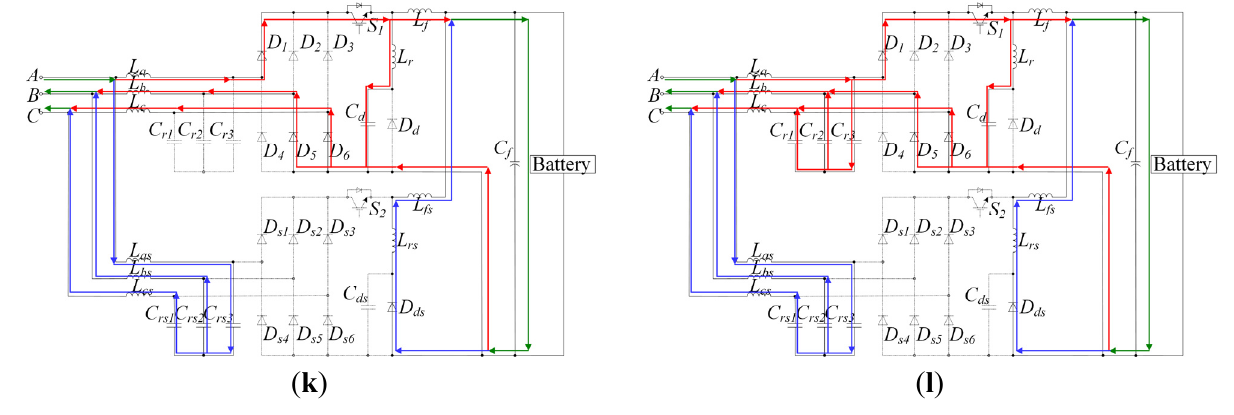
Figure 7. Equivalent circuits of each interval. ( a ) t 0 –t 1 ; ( b ) t 1 –t 2 ; ( c ) t 2 –t 3 ; ( d ) t 3 –t 4 ; ( e ) t 4 –t 5